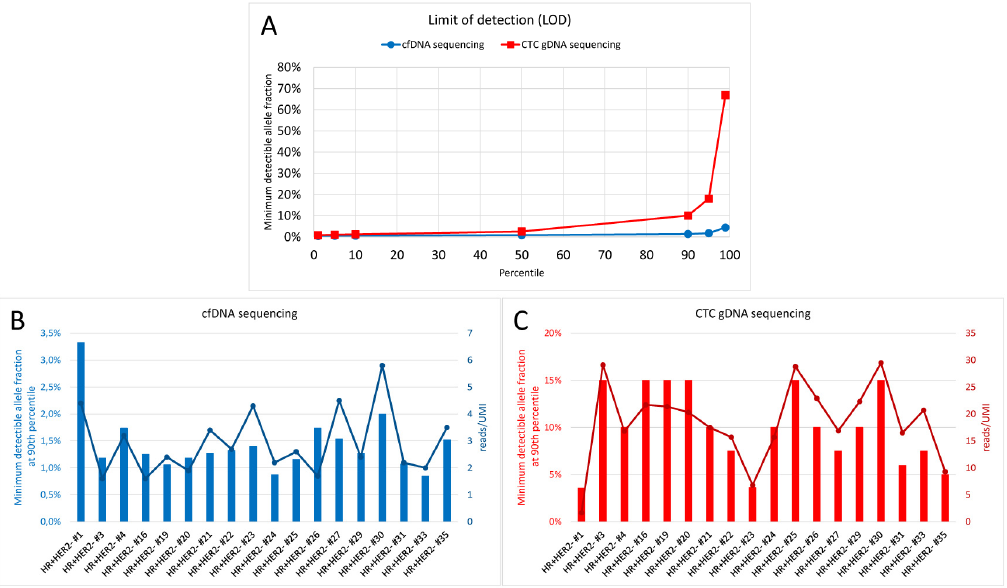
Figure 1. Limit of detection of the cfDNA and circulating tumor cell (CTC) gDNA sequencing analysis. ( A ) Lowest detectable variant allele frequency called with a confidence of 0%–99% is plotted for cfDNA (blue) and CTC gDNA (red). The lowest detectable variant allele frequency called with 90% confidence is plotted for each of the 18 patient samples in comparison to the mean number of reads per UMI in the sample for cfDNA ( B ) and CTC gDNA ( C ).